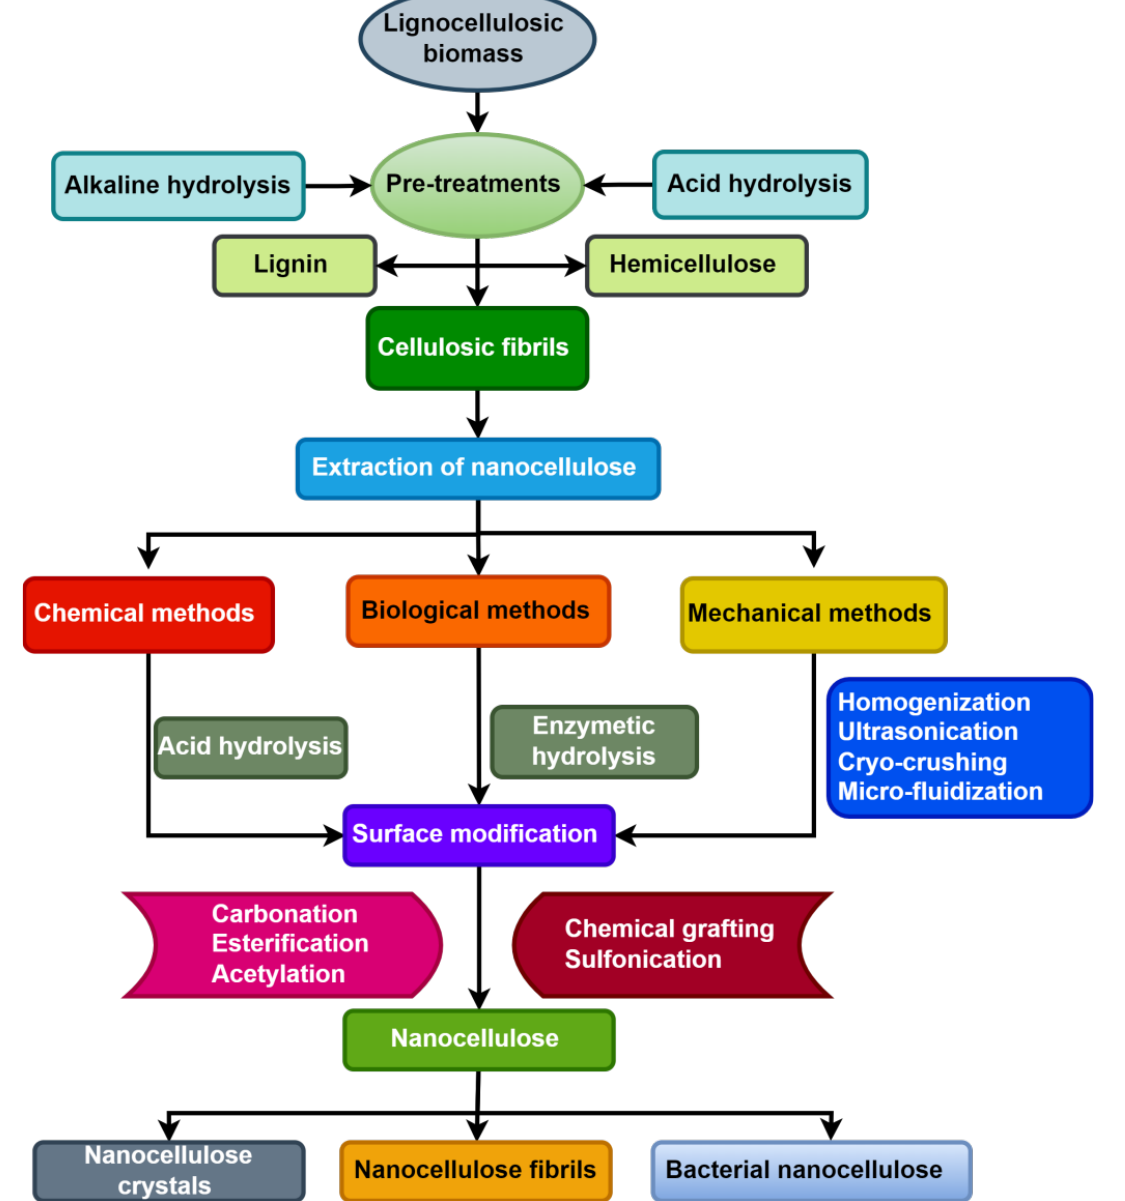
Figure 7. Flow chart of isolation process of nanocellulose from lignocellulosic biomass.